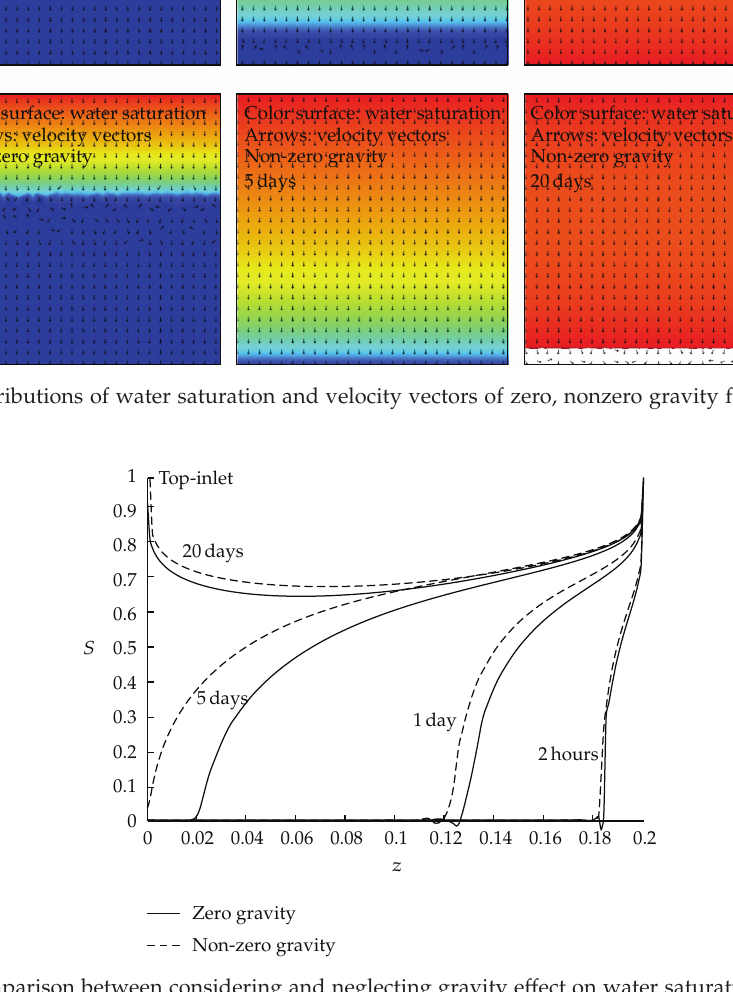
Figure 9: Comparison between considering and neglecting gravity e ff ect on water saturation for the top- inlet case, at x (cid:8) 0 .